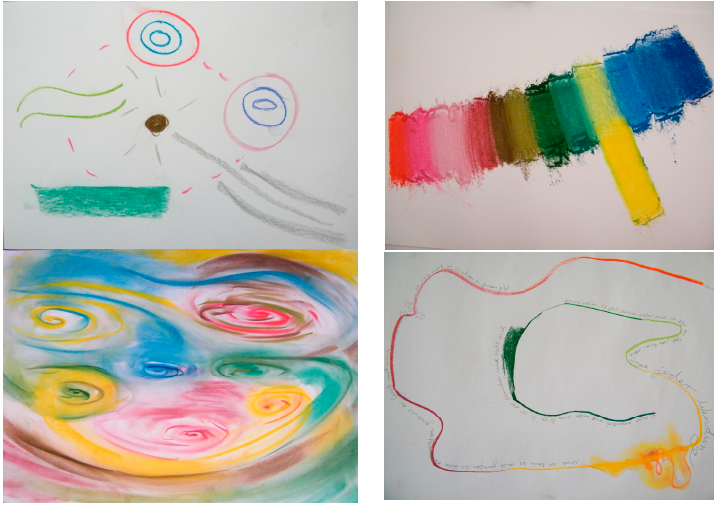
Figure 7 . The third four examples of the creations with paper, color, and/or words that emerged from the artistic inquiry in this study.